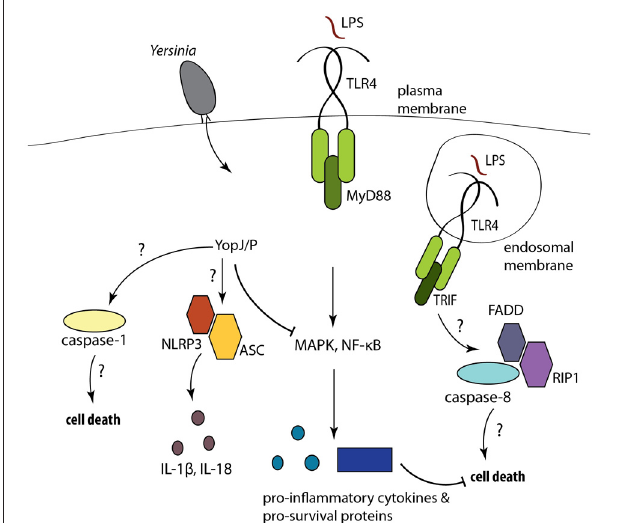
FIGURE 1 | Yops are injected into phagocytes during Yersinia infection. YopJ/P inhibits NF- κ B and MAPK signaling, preventing the expression of pro-inflammatory cytokines and pro-survival molecules, resulting in cell death. YopJ also activates caspase-1 processing and IL-1 β and IL-18 release. The mechanisms of cell death and inflammasome activation are not